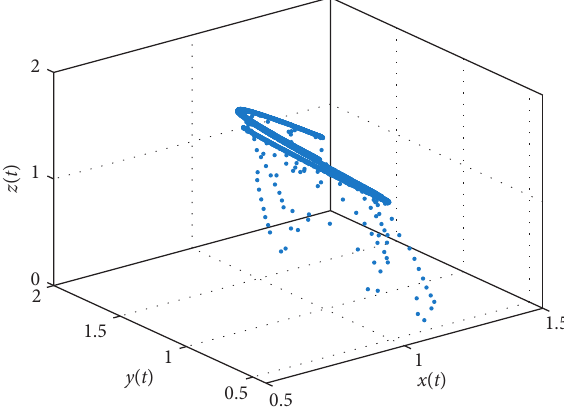
Figure 10: Strange attractors for α